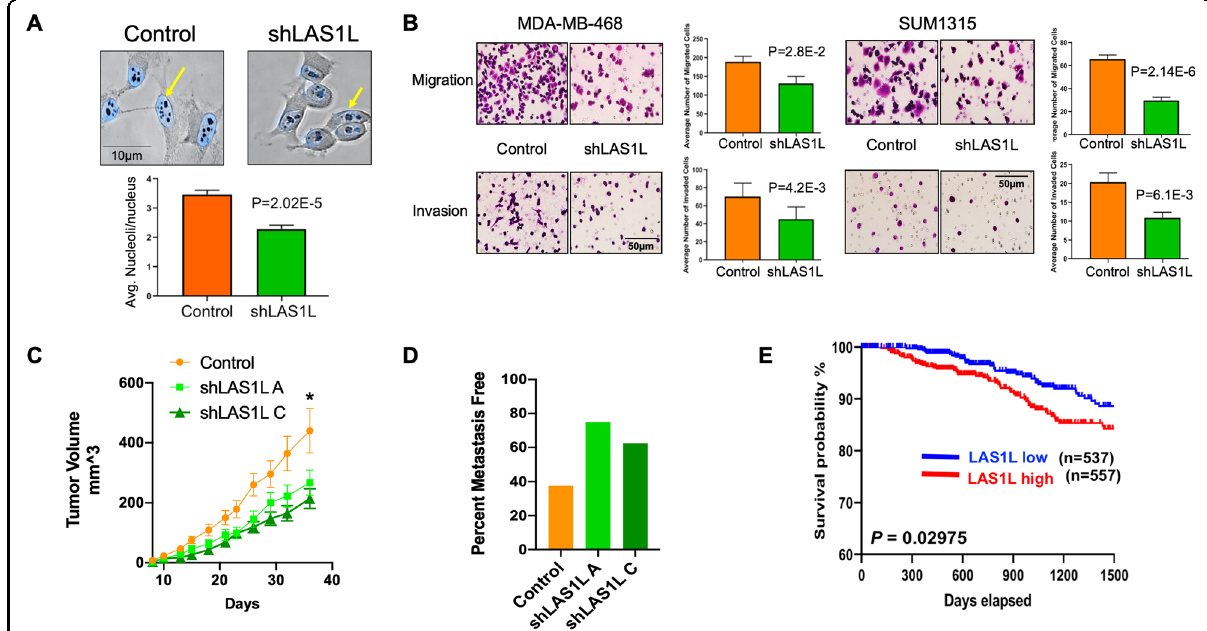
Fig. 5 Knockdown of LAS1L leads to a reduction in tumorigenic and metastatic properties in TNBC. A Stable knockdown of LAS1L using short hairpin RNA results in a signi fi cant reduction in nucleolar number. Statistical signi fi cance was determined by T -test and error bars to represent SEM. B Knockdown of LAS1L in TNBC cells results in a signi fi cant reduction in the invasive and migratory capability of cells. Statistical signi fi cance was determined by T -test and error bars to represent SEM. C Growth of orthotopic xenografts of SUM1315 cells is signi fi cantly reduced following stable knockdown of LAS1L. Statistical signi fi cance was determined by two-way ANOVA followed by Dunnett ’ s post hoc test for tumor growth at respective time points and error bars represent SEM. * Represents signi fi cant statistical difference was reached for comparison of the control group compared to shLAS1 A as well as shLAS1L C growth curves for all days from day 18. D Lungs of mice with orthotopic xenografts of SUM1315 were examined for overt metastases. The incidence of metastasis was notably low for LAS1L knockout xenografts. E For survival analysis, the patient ’ s LAS1-L RNA expression data, measured by RNAseq — IlluminaHiSeq for 1101 breast cancer primary tumors (cohort: TCGA Breast Cancer BRCA) was accessed from a public data portal (https://xenabrowser.net) Sep. 2020. Data were extracted for analysis. Normalized RNA-seq data was used as LAS1-L gene expression values, and the median was used to classify samples into high and low expression groups for overall survival analysis. A Kaplan – Meier curve was generated, and a log-rank test